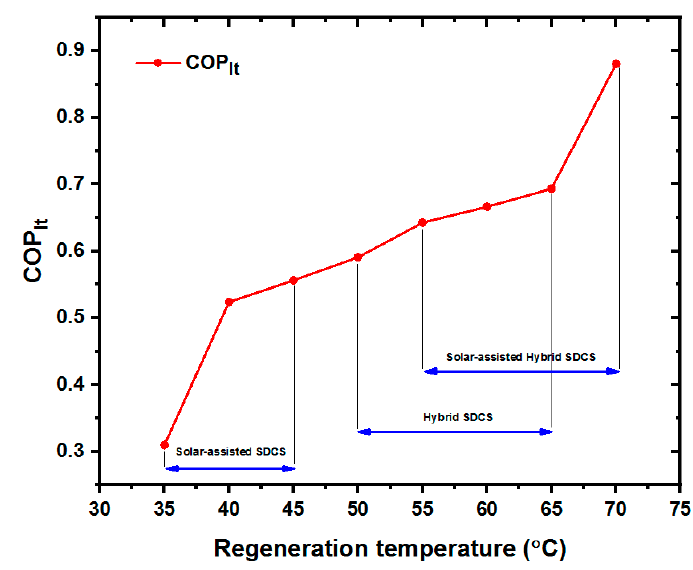
ff ect of regeneration temperature on latent heat performance ( COP Figure 10. Effect of regeneration temperature on latent heat performance ( COP lt ). Figure 10. E